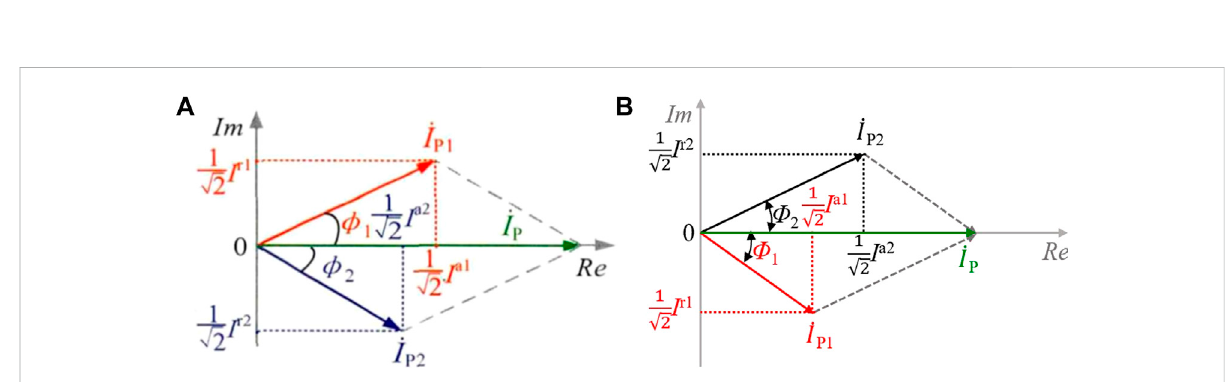
FIGURE 7 The vector diagram of currents decomposed by the coil current. (A) The active currents decomposed diagram. (B) The reactive currents decomposed